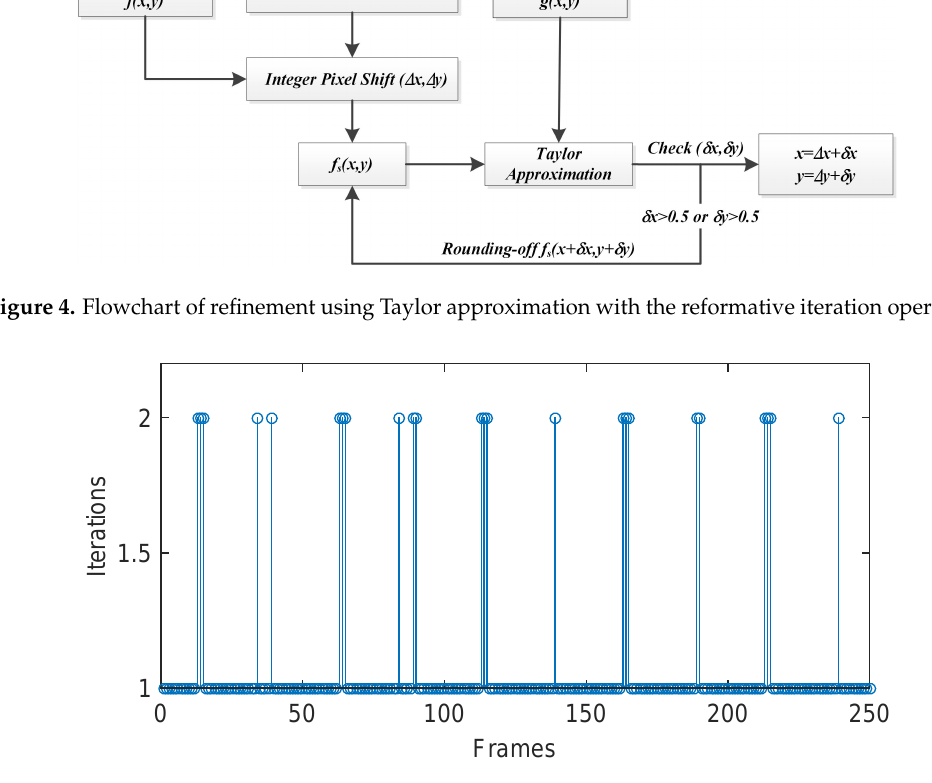
Figure 5. Number of iterations using the modified Taylor approximation refinement in the simulation test.